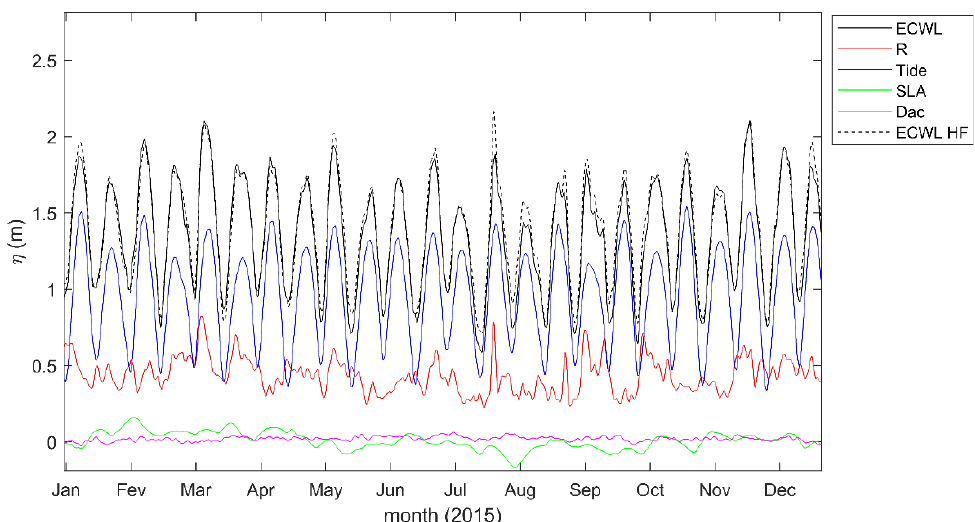
Figure 4. Illustration of the daily (maximum) contributors to Extreme Coastal Water Level over the full 2015 year. Black dashed line represents the interaction between hourly tide and other components.